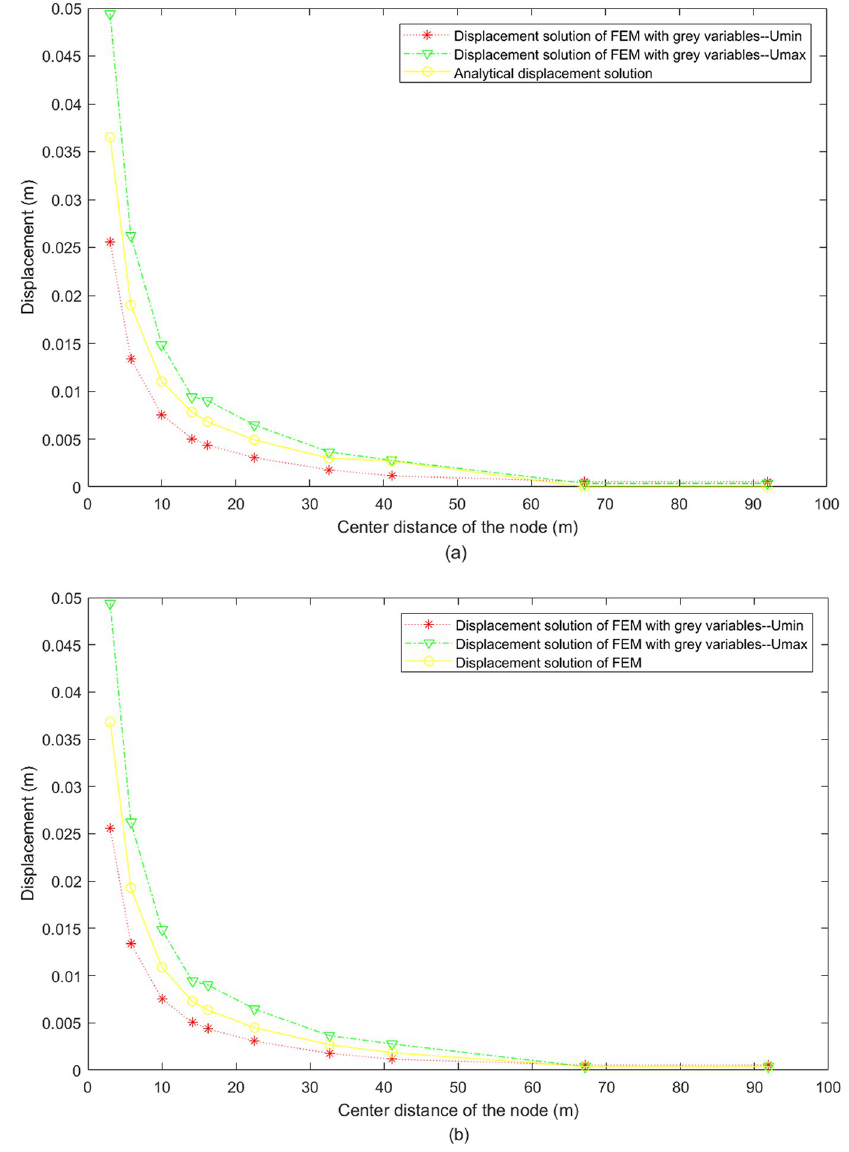
Fig 12. Comparison of FEM with grey variables (a) with analytical solution and (b) with classical FEM solution. 2. An example of a deep-buried circular mining tunnel was executed, and the displacement solution of FEM with grey variables was obtained and compared with the analytical dis- placement solution and classical FEM displacement solution. The comparison results show that both the analytical displacement solution and classical FEM displacement solution were included in the chaos of grey displacement calculated by FEM with grey variables, and the accuracy of calculation results was improved with more refined mesh size. This demon- strates that the results of the proposed grey numerical model contain more information (i.e. the bigger chaos of the displacement), and the potential danger of losing some information